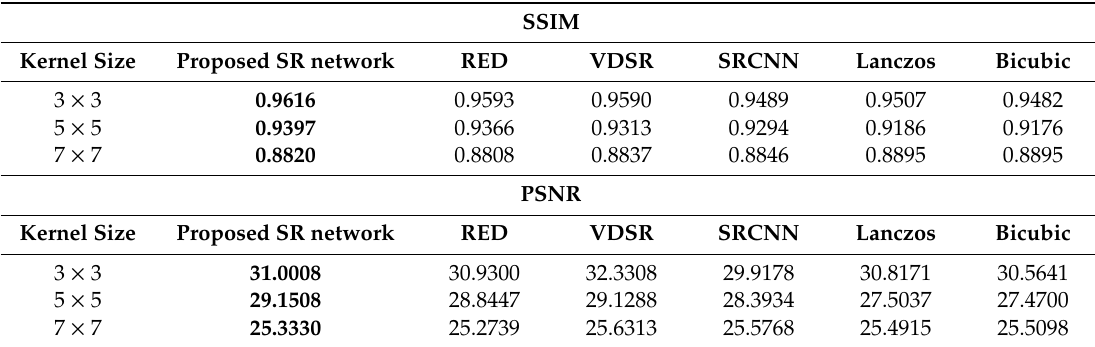
Table 3. Average PSNR and SSIM in di ff erent kernel sizes of gaussian filters.